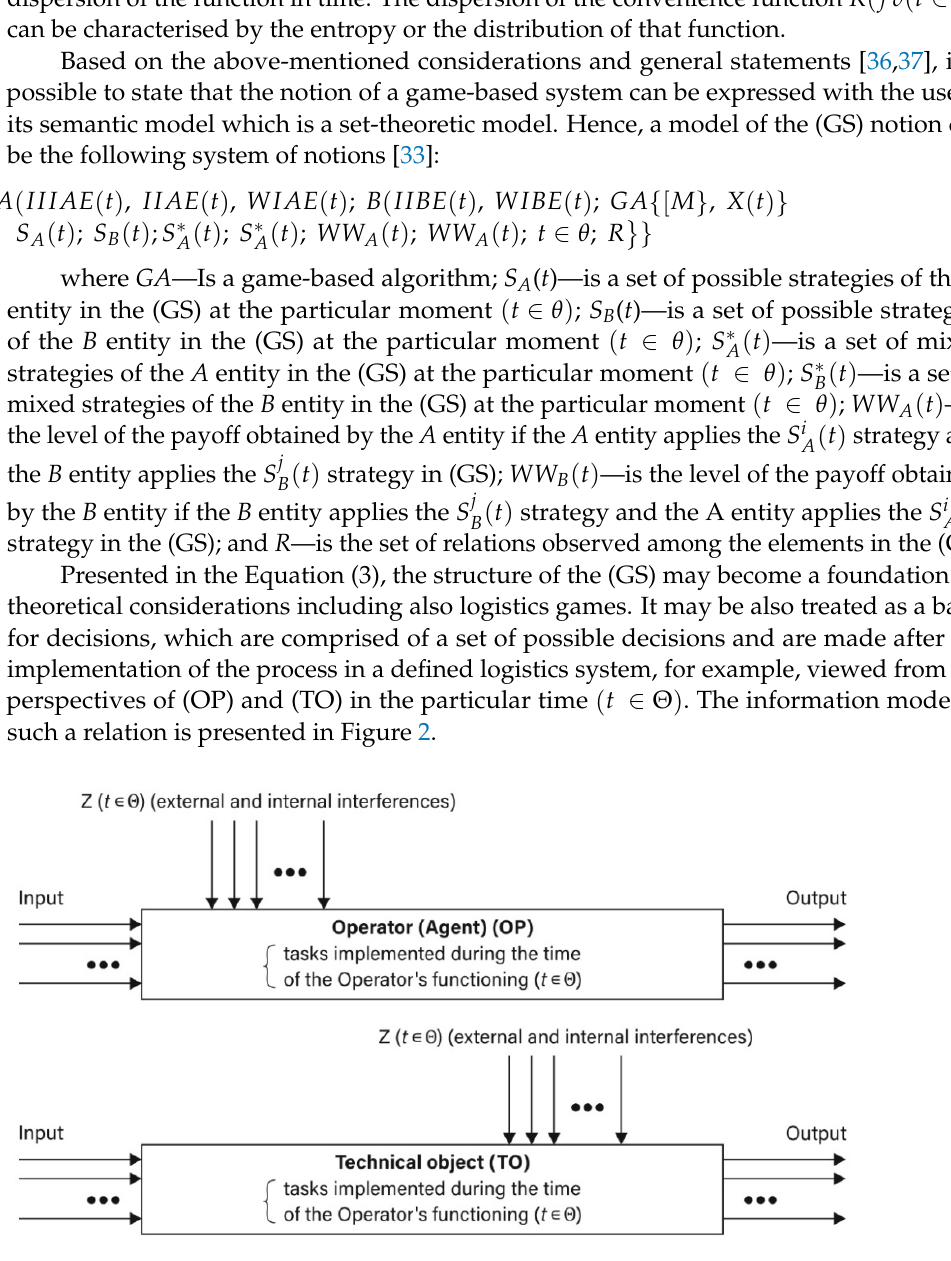
Figure 2. Information model (OP) and (TO) in the time ( t ∈ Θ ) : adapted from